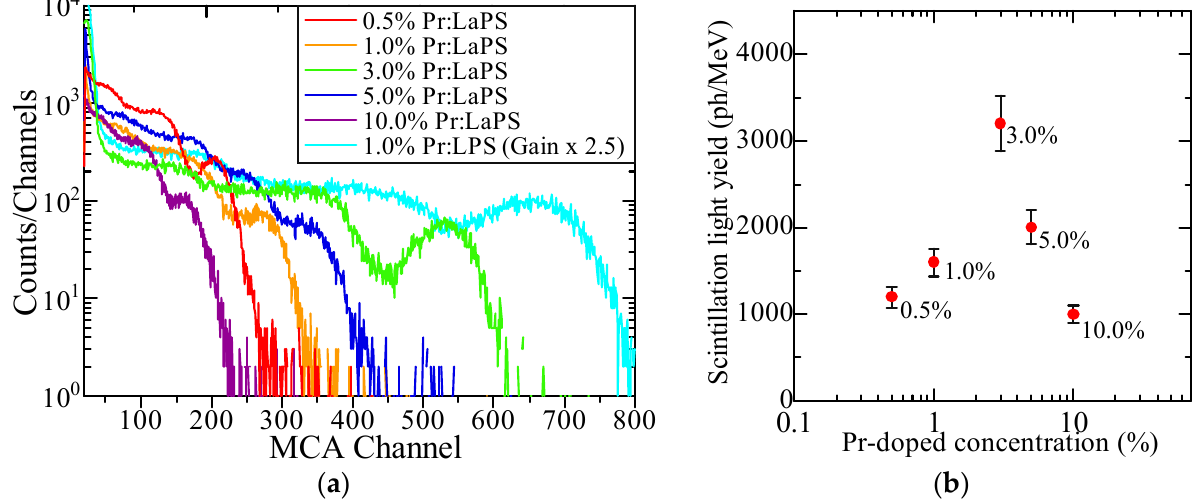
Figure 9. 137 Cs, 662 eV γ -ray: ( a ) pulse-height spectra of Pr-doped LaPS samples with the Pr-doped LPS spectrum; ( b ) scintillation light yield of LaPS samples plotted against Pr concentration. Table 1. Pr-doped LaPS summarized data.